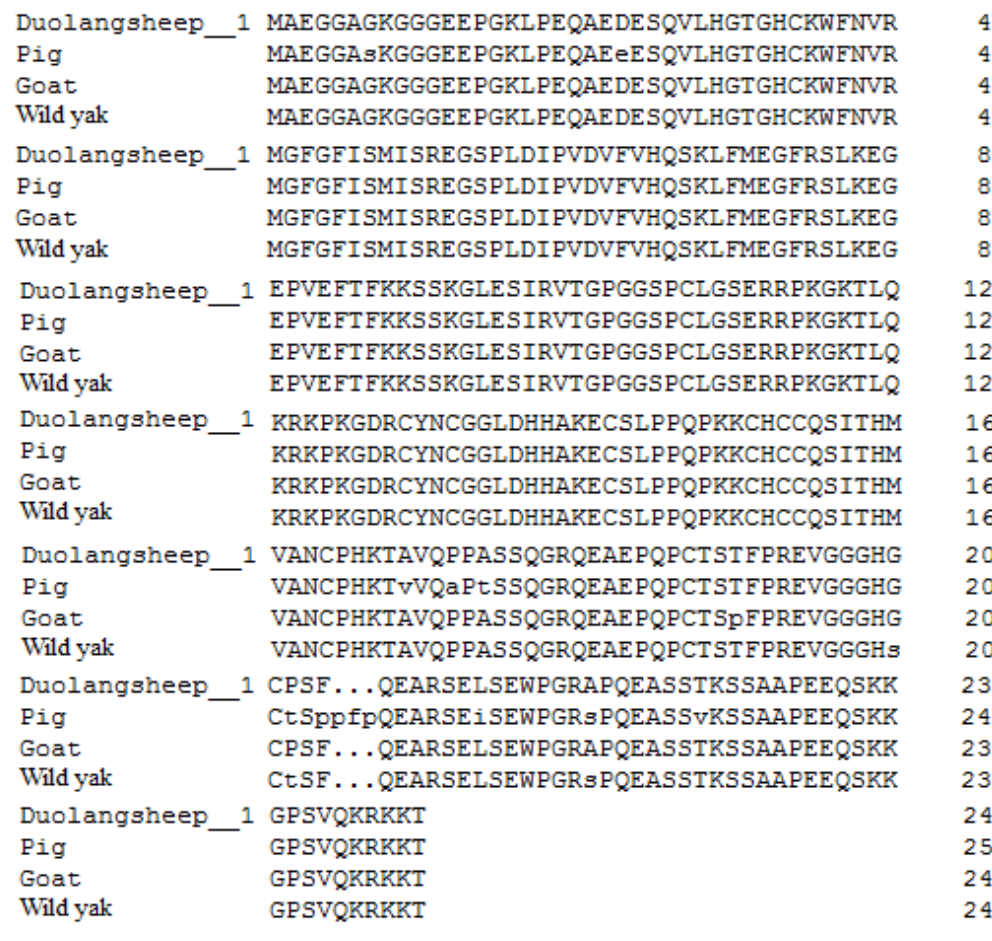
Figure 1. Alignment of the amino acid sequences of the predicted Duolang sheep lin-28 homolog B protein with those of pig (XP_020935097.1), goat (XP_005684673), and wild yak